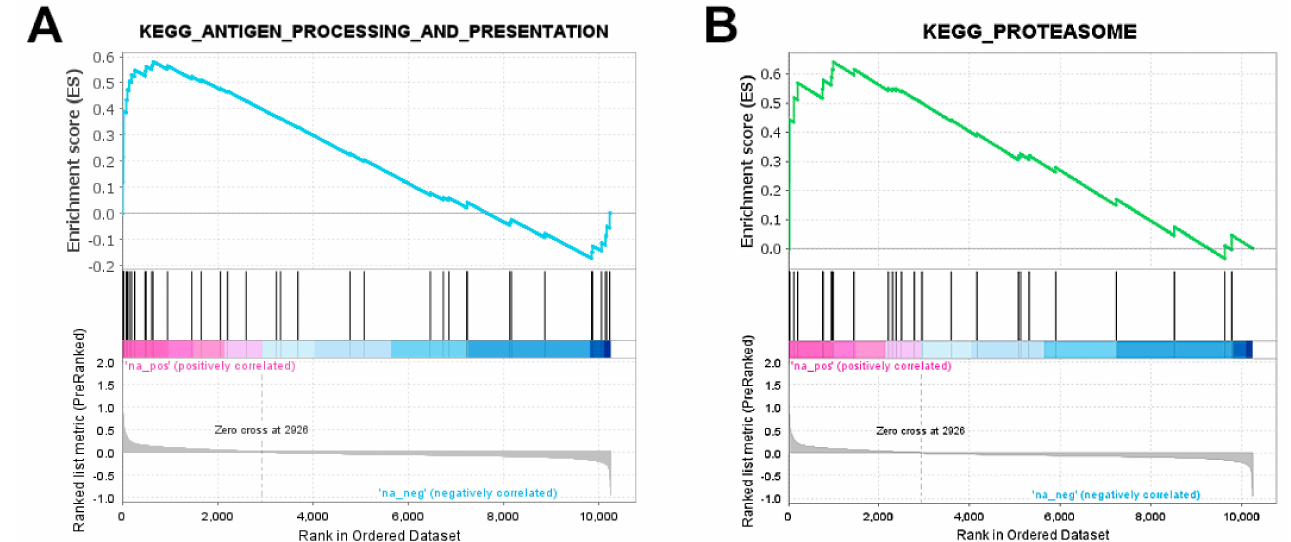
Figure 3. GSEA enrichment plots . Profile of the running ES score (upper boxes), and positions of the gene set members on the rank-ordered list from the microarray experiments (lower boxes) for ( A ) the antigen processing and presentation and ( B ) proteasome KEGG pathways, respectively. The leading edge comprises that portion of the gene set between the (absolute) ES maximum and the nearest edge of the ranked